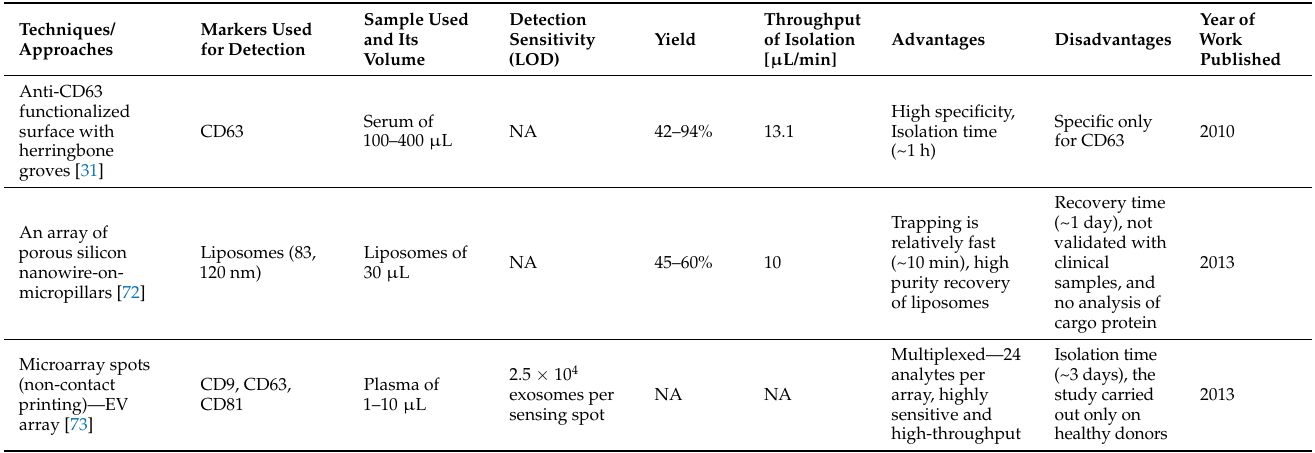
Table 1. Immunoaffinity approach integrated with microfluidics technique to capture and detect exosomes.